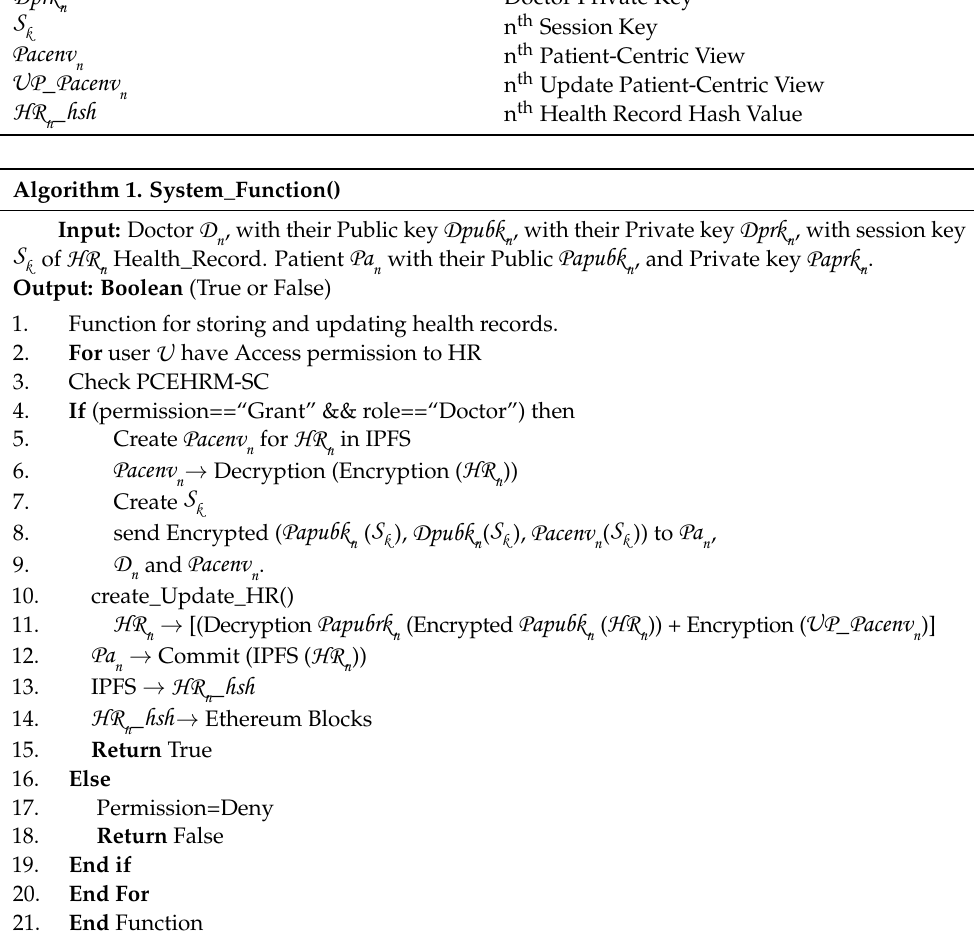
Algorithm 1 calls the create_Update_HR() function of Algorithm 2 to start updating